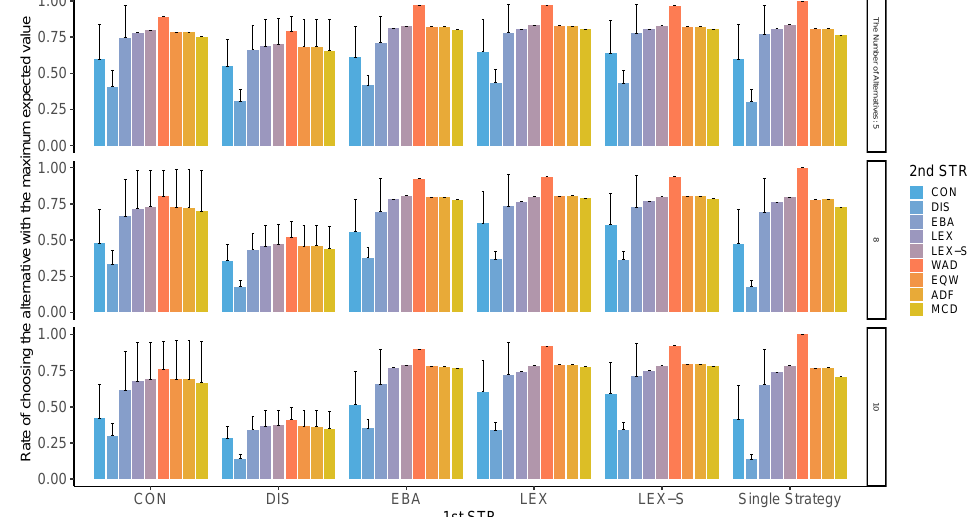
Figure A14. Best choice rate in two-stage decision-making when three alternatives are left in the second stage. Note: ADF: additive difference; CON: conjunctive; DIS: disjunctive; EBA: elimination by aspects; EQW: equal-weighted strategy; LEX: lexicographic; LEX-S: lexicographic semi-order; MCD: majority of confirming dimensions; STR: strategy; WAD: weighted